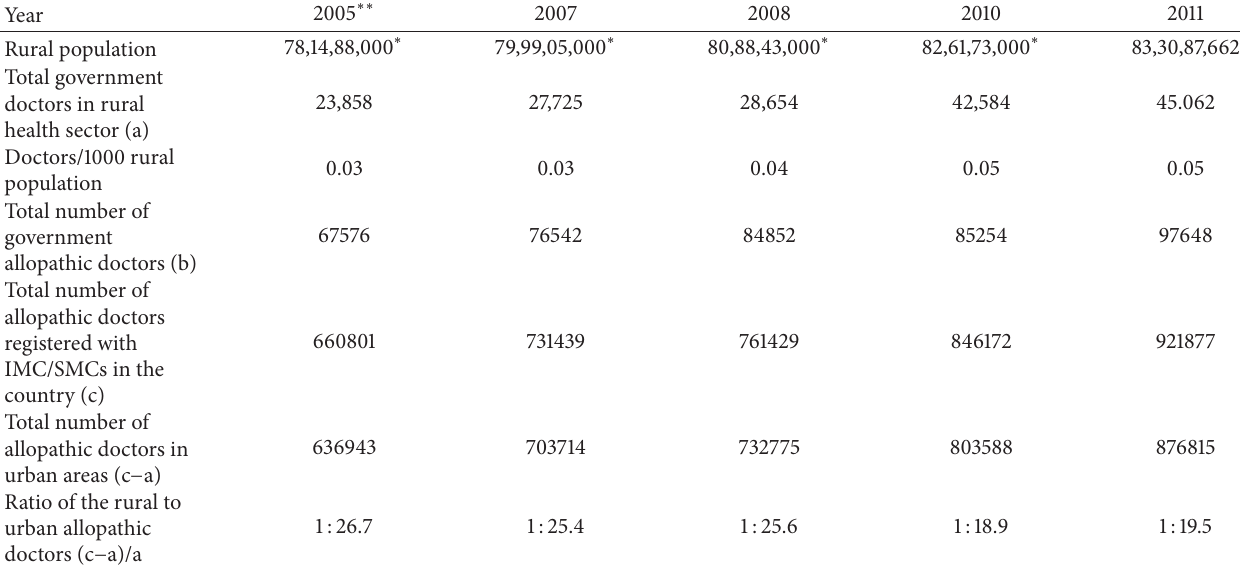
Table 10: Availability of allopathic doctors in the rural healthcare set up in